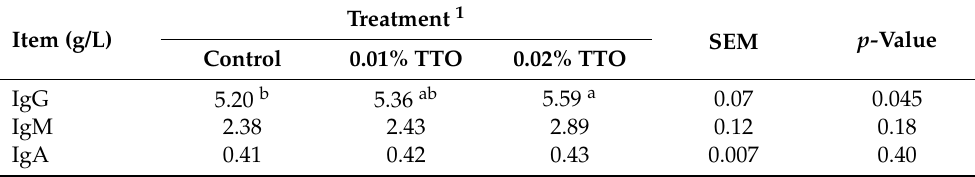
Table 6. Effects of TTO on IgG, IgA, and IgM in postpartum dairy